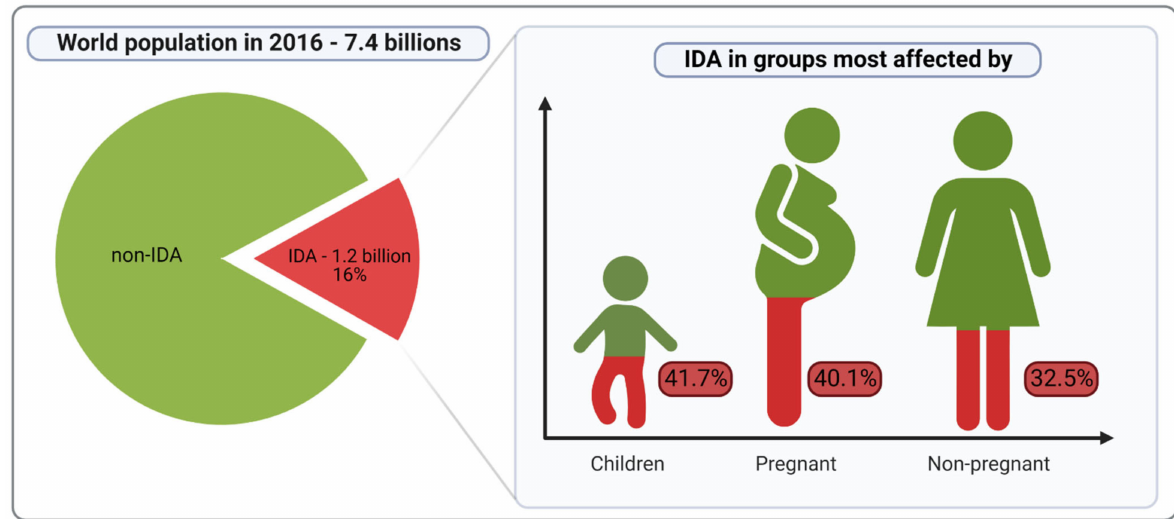
Figure 1. Occurrence of iron deficiency anemia. IDA—iron deficiency anemia; Non-IDA—anemia without